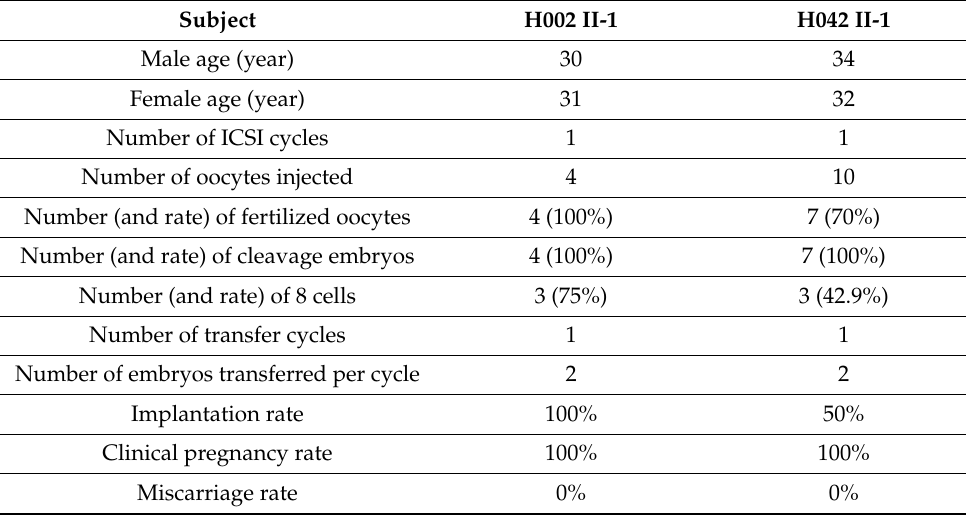
Table 3. Clinical outcomes of ICSI cycles using the spermatozoa from men harboring hemizygous USP26